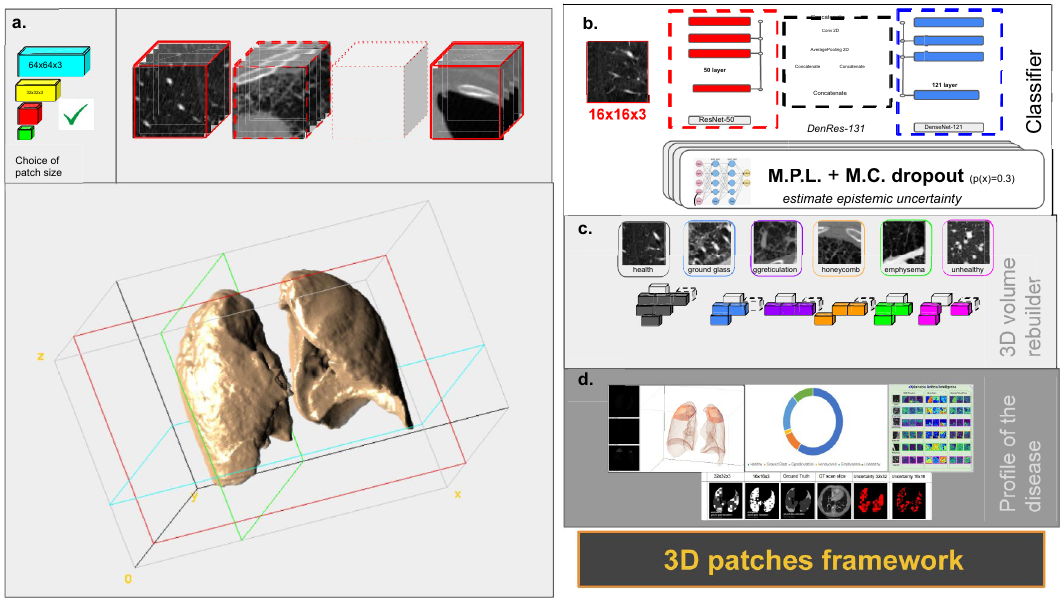
Figure 1. The artificial intelligence framework to diagnose pulmonary hypertension. ( a ) The extraction of 3D patches pipeline. We used four different size of 3D patches to discrete the lungs region, 64 × 64 × 3 , 32 × 32 × 3 , 16 × 16 × 3 , and 8 × 8 × 3 . ( b ) Trained deep learning classifier is used to classify each 3D patch in one of the six classes (healthy, ground-glass, ground glass reticulation, honeycomb, emphysema or unhealthy). ( c ) The 3D volume rebuild of the lungs anatomy. ( d ) Profile of the disease of a specific patient. The profile includes the portion of the diseases appeared in the patient’s profile, the 3D anatomical lung model with the diseased areas, the explainability of the deep learning features and the uncertainty estimation of the